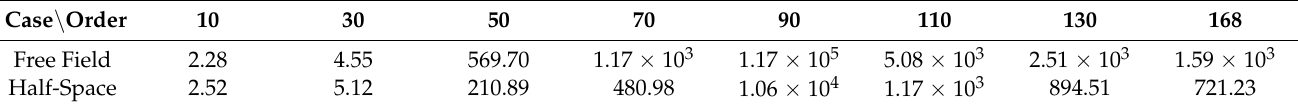
Figure 10. The variation of 𝛾 with the increase of ARM order when 135 uniformly arranged meas- urement points are used. Compared with Table 3, it could be found in Table 4 that, when the quantity of meas- urement points increases to 135, the values of 𝛾 could also be quite low at high orders, which is beneficial to find the balance between computation convergence and prediction robustness. Repeating the simulation in Section 3.1, the prediction errors are shown in Figure 11. It could be seen that, with more measurement points, the prediction results become much better because it is easy to obtain optimal solutions of 𝜷 that satisfy the